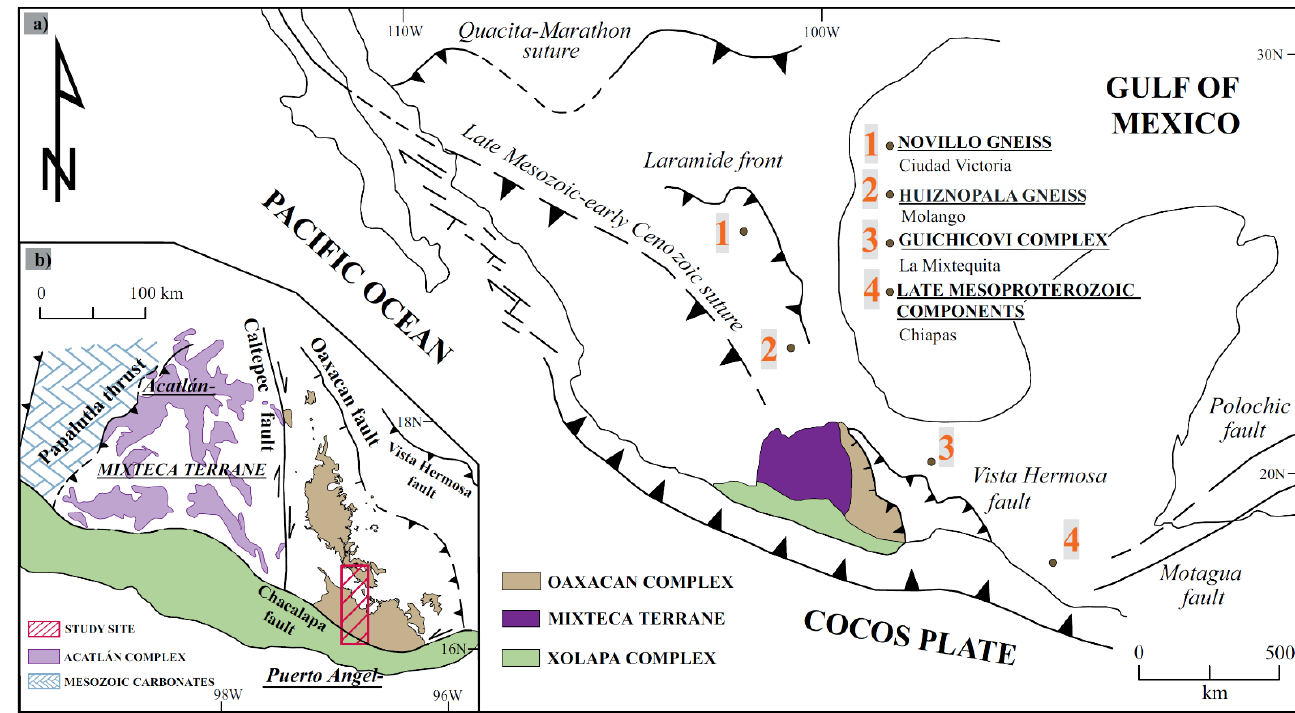
Figure 1. ( a ) Map of Mexico showing the main geological features. The four exposures of Grenvillian-age granulite-facies metamorphic rocks in eastern and southern Mexico are the Novillo Gneiss, Huiznopala Gneiss, Oaxacan Complex, and Guichicovi Complex. In the state of Chiapas, there are late Mesoproterozoic components that have been reworked by Ordovician magmatism and metamorphism [22]. ( b ) Map of southwestern Mexico showing the Xolapa, Acatlán, and Oaxacan metamorphic complexes (modified from [30]). The study area is in a red line pattern.